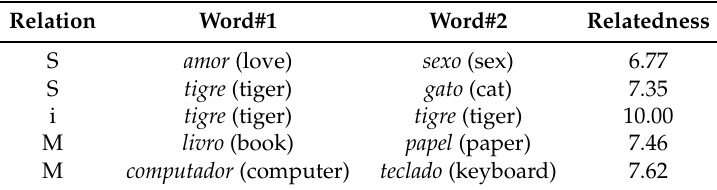
Table 2. First five lines of the Portuguese WordSim-353 test with original English translation. Identified relations are: synonyms (S), identical tokens (i), second is part of the first